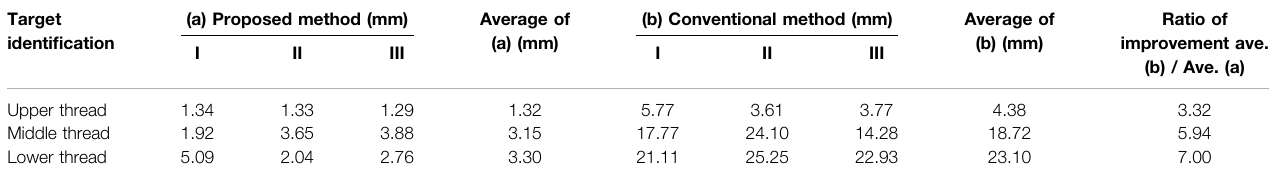
TABLE3| Comparisonofthebeamwidthsathalfmaximumofeachpeakmagnitudeinthelateraldirectionin(a)theproposedmethodand(b)theconventionalmethodofthe dynamic focusing for reception, and improvement ratio of the spatial resolution of the images obtained by considering the estimated curved surface. Target identi fi